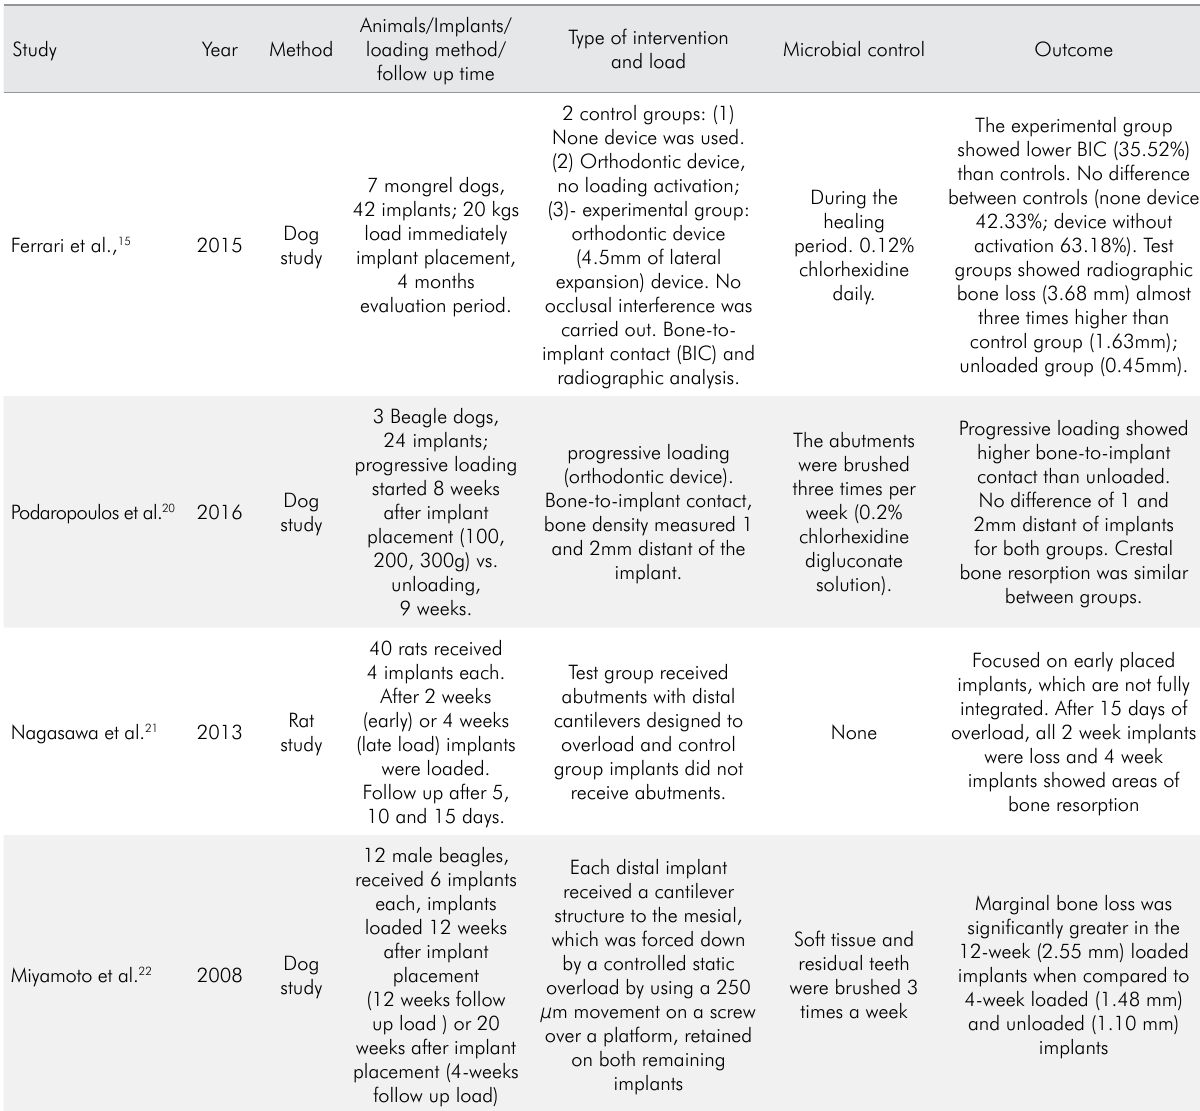
Table 4. Study characteristics and quality assessment of the animal studies included for the review. Study Method